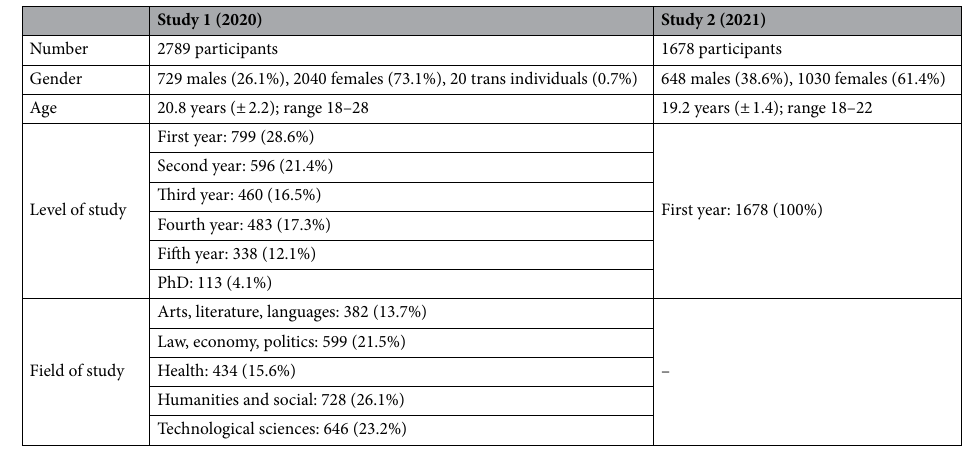
Table 3. Sociodemographic characteristics of the